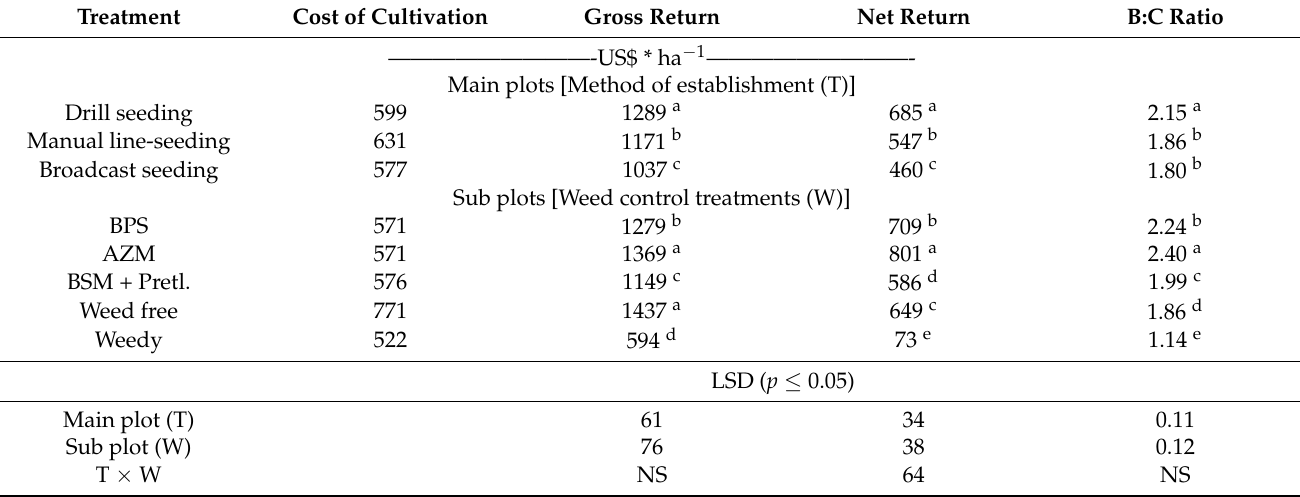
Table 5. Economics of dry direct seeded rice as influenced by different establishment methods and weed control